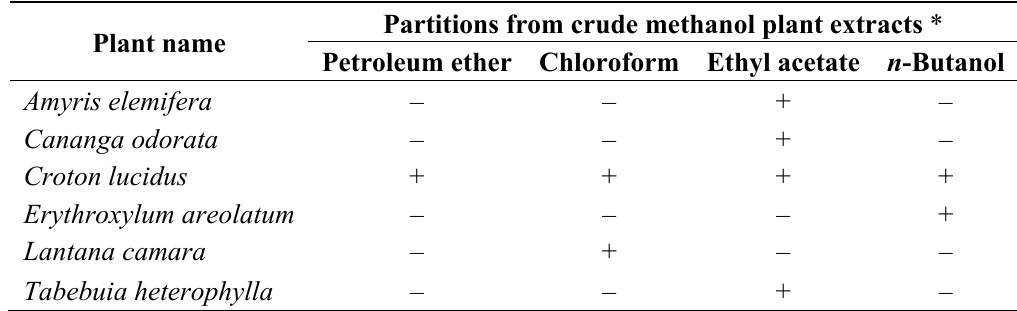
Table 2. Screening of plant extract partitions for inhibition of uPA.